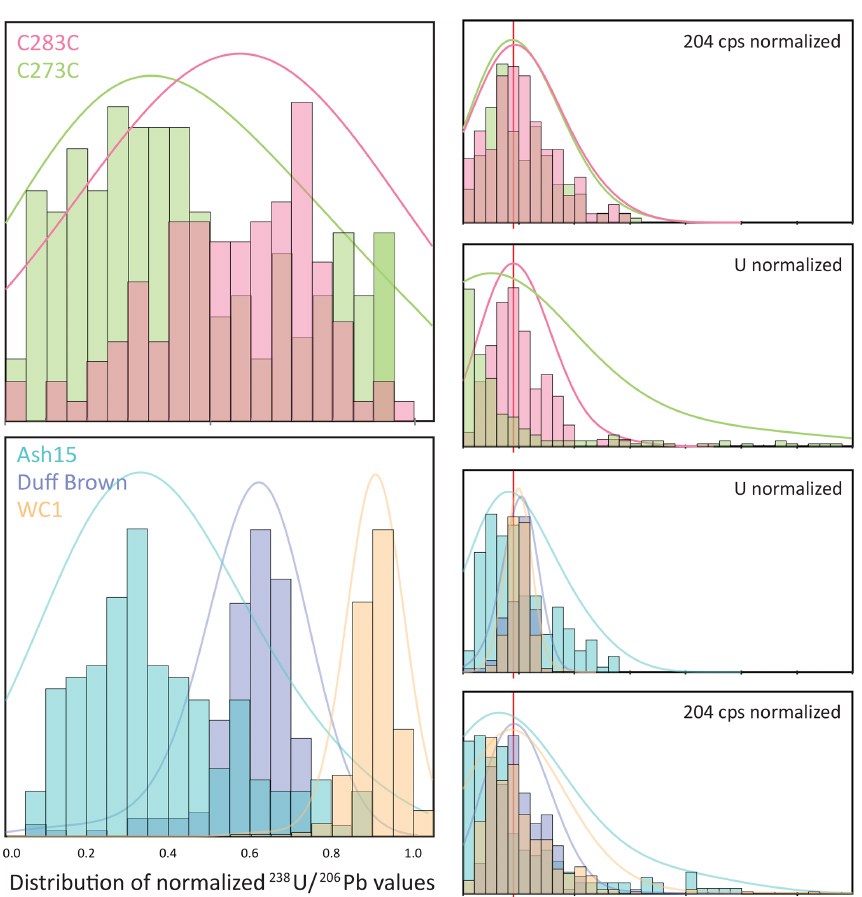
Figure 4. Left-hand plots show the difference in distribution of 238 U / 206 Pb ratios in reference materials and unknowns; ratios are normal- ized to the 238 U / 206 Pb ratio of the age of the sample. Reference materials Duff Brown and WC-1 have the smallest variation in 238 U / 206 Pb ratios, which correlates well with the distribution of their U and Pb contents (left-hand plots). Reference material ASH15 and unknown sam- ple C283C still have a wider lognormal distribution, reflective of their larger distribution of U and Pb contents relative to Duff Brown and WC-1. Unknown sample C273C has a more uniform distribution of 238 U / 206 Pb ratios, reflecting its largest distribution of U